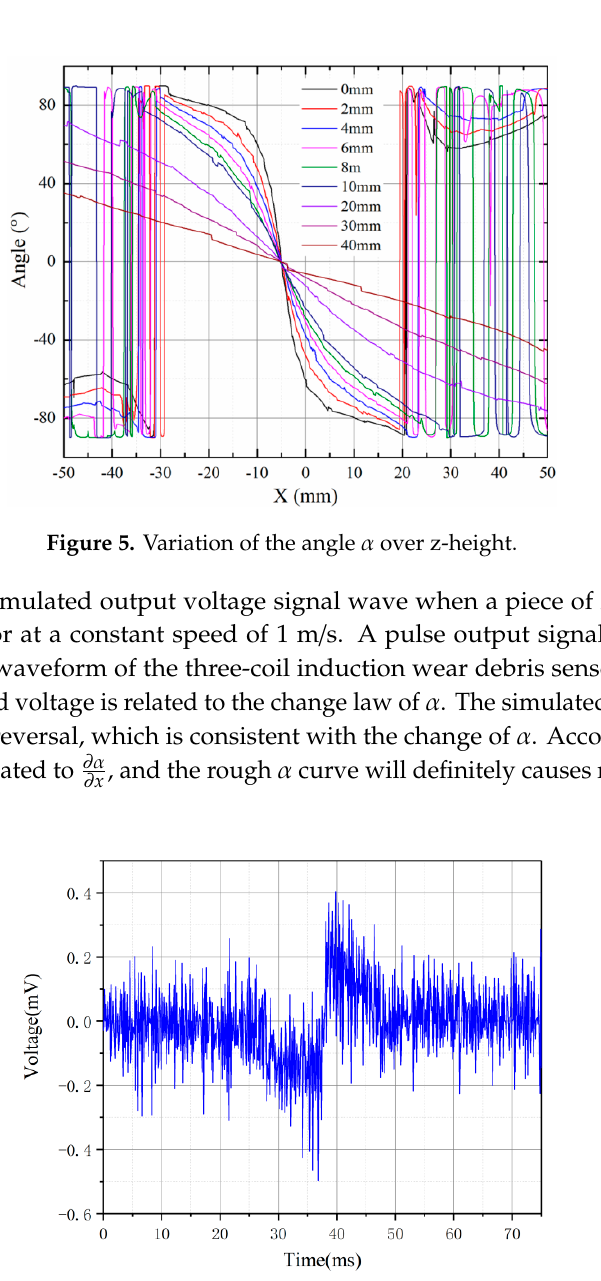
Figure 6. Simulation wave (0.5 mm × 0.5 mm × 0.5 mm iron debris, 1000 AN magnetic potential, 1 m/s).